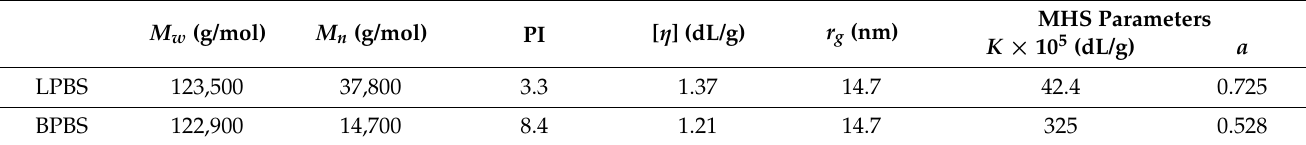
Table 2. Molecular characteristics of linear and branched PBS.